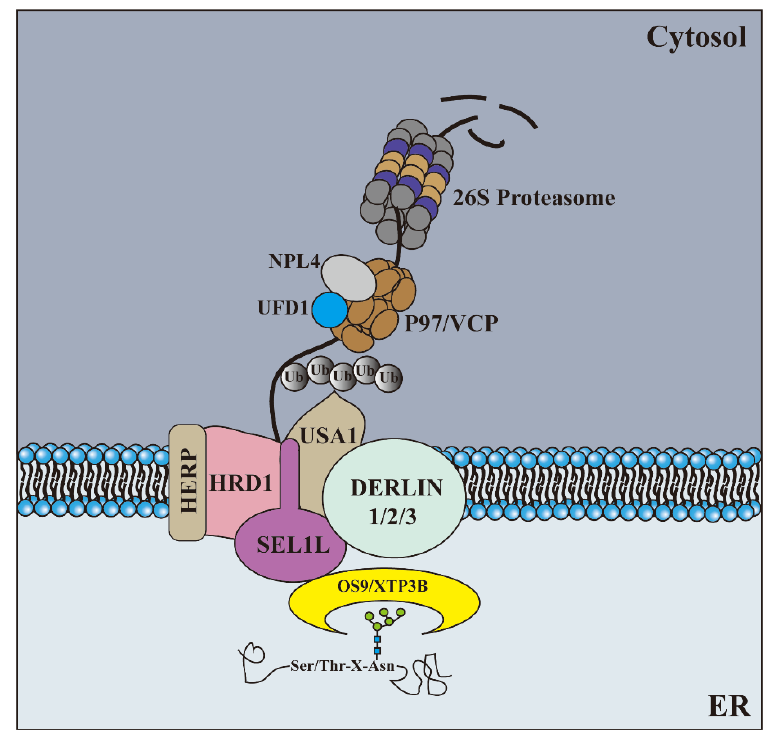
Figure 2. The processes of ERAD. Misfolded proteins are recognized in the ER by different quality control mechanisms, which escort terminally misfolded polypeptides to a putative channel. Cytoplasm-exposed lysine residues are ubiquitinated by ubiquitin ligases. Dislocation is completed with the help of the Cdc48p/p97 complex, and membrane-extracted substrates are conveyed to the proteasome by accessory factors. Table 1. List of components involved in ERAD.